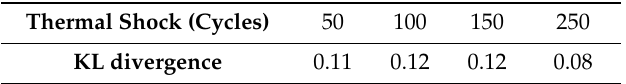
Table 2. Kullback–Leibler (KL) divergence between autocorrelation functions.